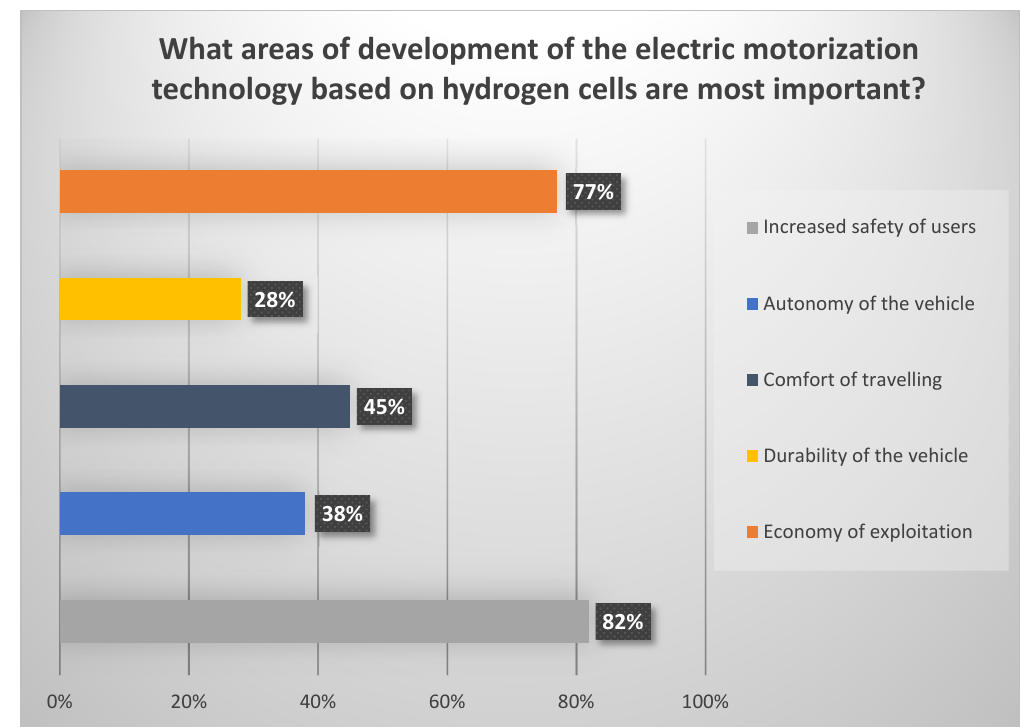
Figure 10. Survey question number 10. Source: own study.